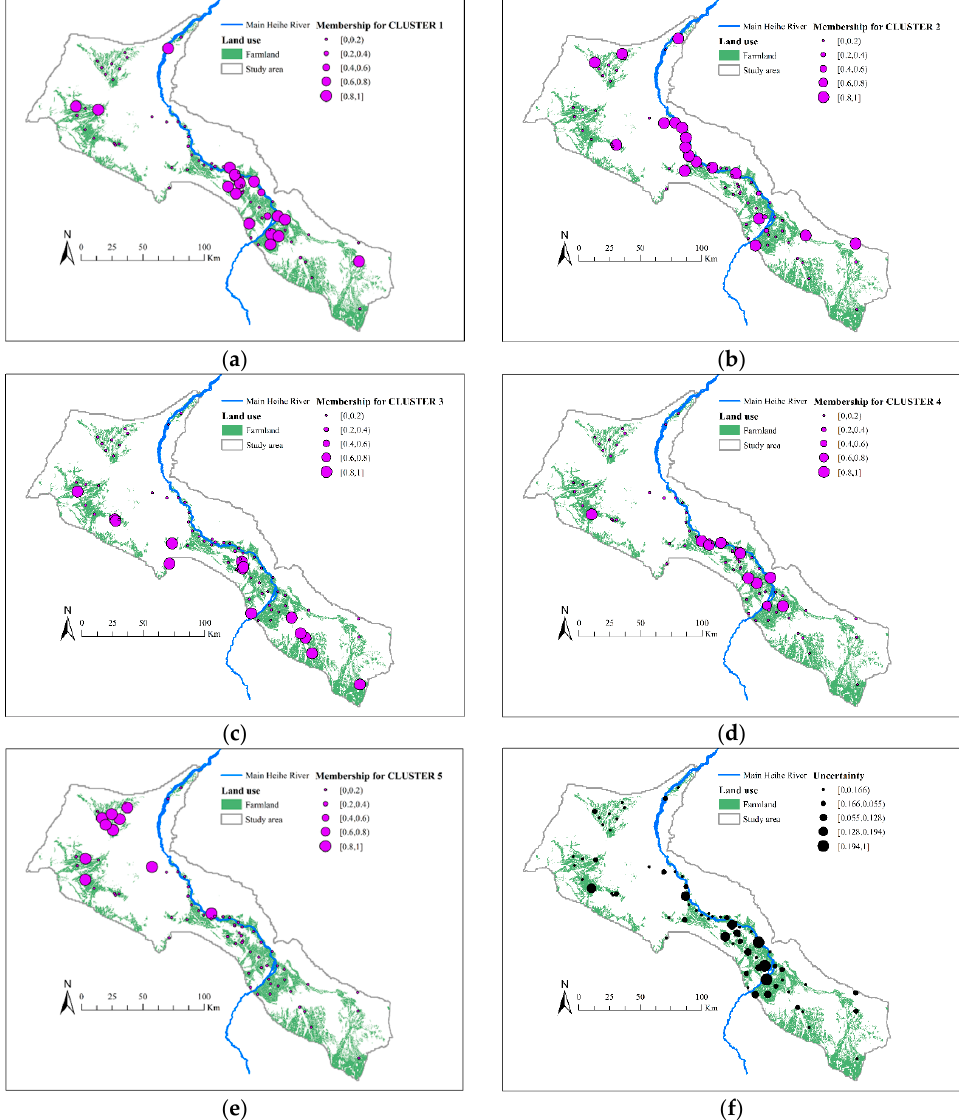
Figure 5. Spatial patterns of the membership probabilities and the clustering uncertainty. ( a – e ) the probabilities of the samples belonging to CLUSTERs 1 to 5, respectively, and ( f ) the clustering uncertainty.